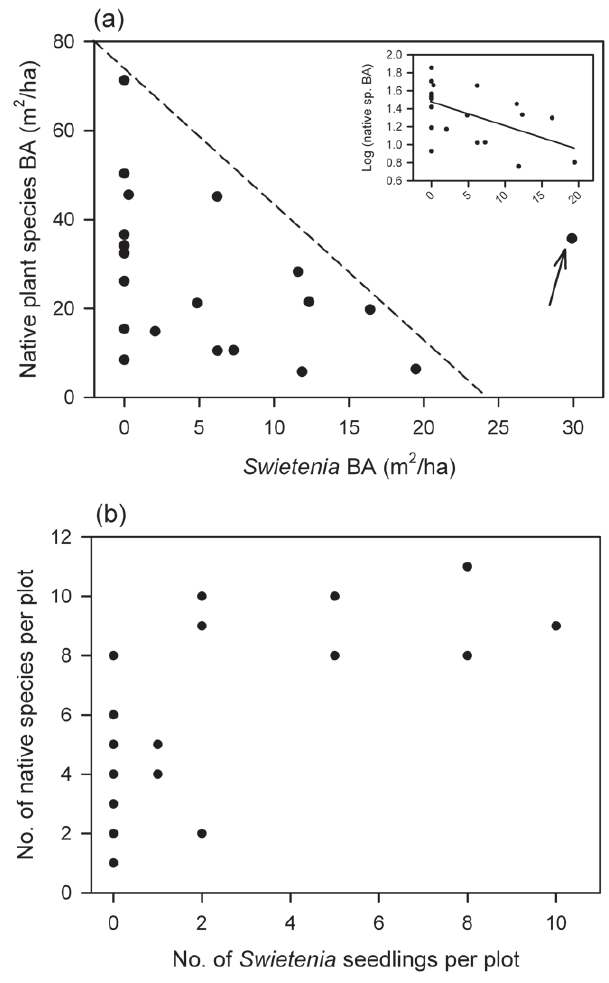
Figure 4. Relationships between native woody plant abun- dance and diversity to the abundance of introduced mahog- any ( Swietenia ) in Cabrits National Park, Dominica. Basal area is expressed on a per ha basis ( a ), and native plant diversity as a function of mahogany abundance is for stems , 50 cm tall ( b ) in respectively n =26 and 21 plots (respectively) at Cabrits National Park, Dominica. In ( a ) the arrow points to an unusual statistical outlier in the data set, and the dashed lined indicates a hypothesized upper boundary to native species recruitment as mahogany’s local dominance increases. All plots were each 78.5 m 2 and surveyed in May 2010. The inset in ( a ) shows a negative relationship between the log-transformed basal area of native species and that of mahogany (with the outlier omitted). In ( b ), although seven data points are visible, in fact there are 16 out of 26 plots with zero (‘0’) mahogany seedlings present because of duplicity in y-values.